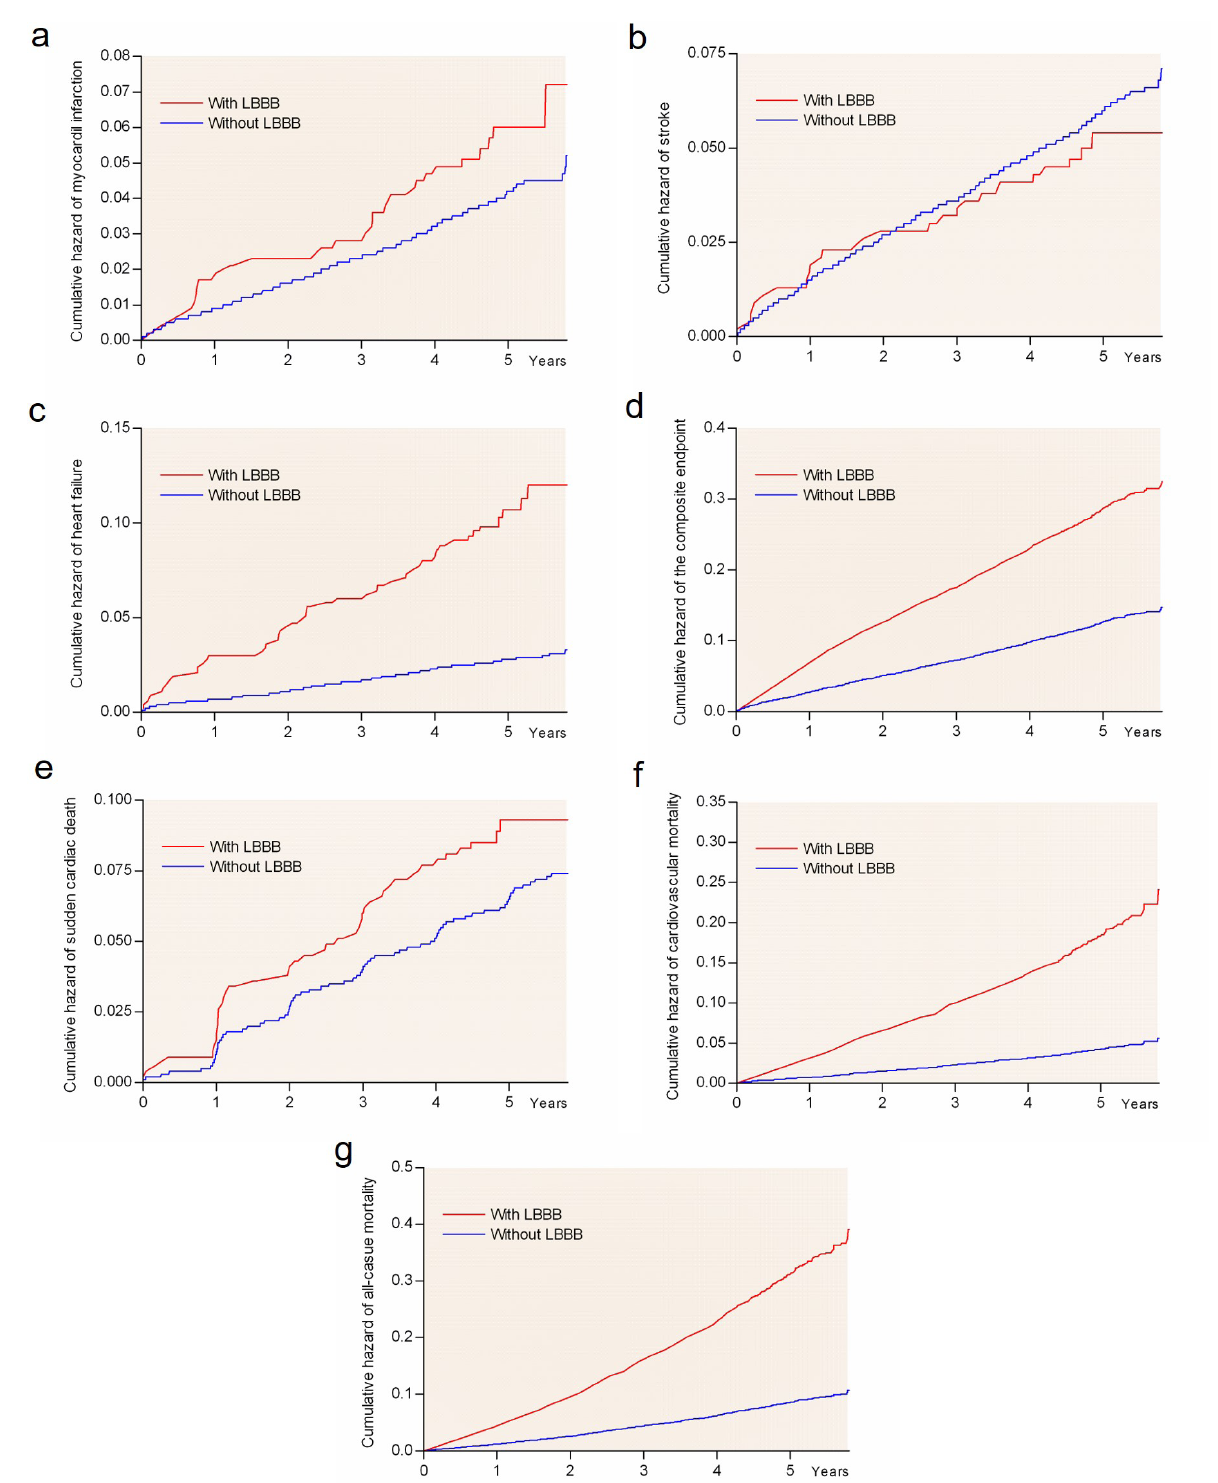
Figure 1. Kaplan–Meier plots of CV complications in patients. Rate of myocardial infarction (panel a), stroke (panel b), heart failure (panel c), the composite endpoint (panel d), sudden cardiac death (panel e), CV death (panel f), and all-cause mortality (panel g) by LBBB